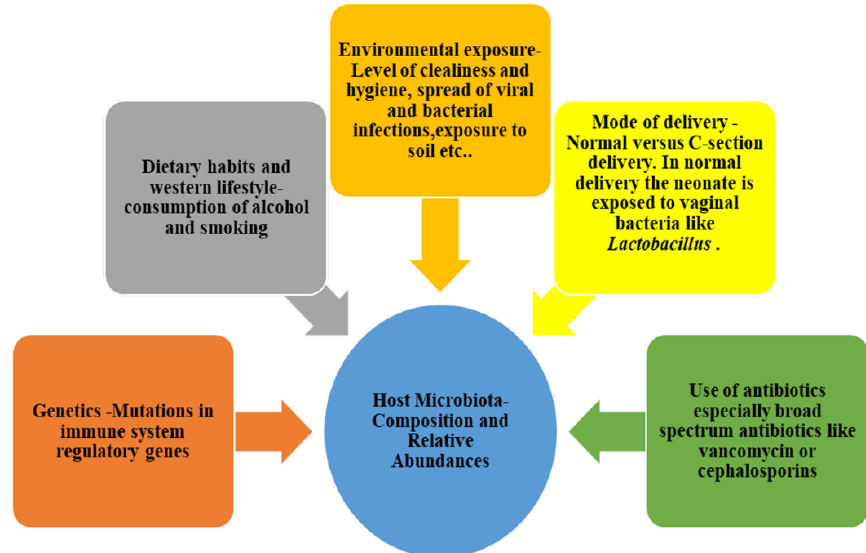
Figure 1. Factors contributing to shaping and changing gut microbiota with time.